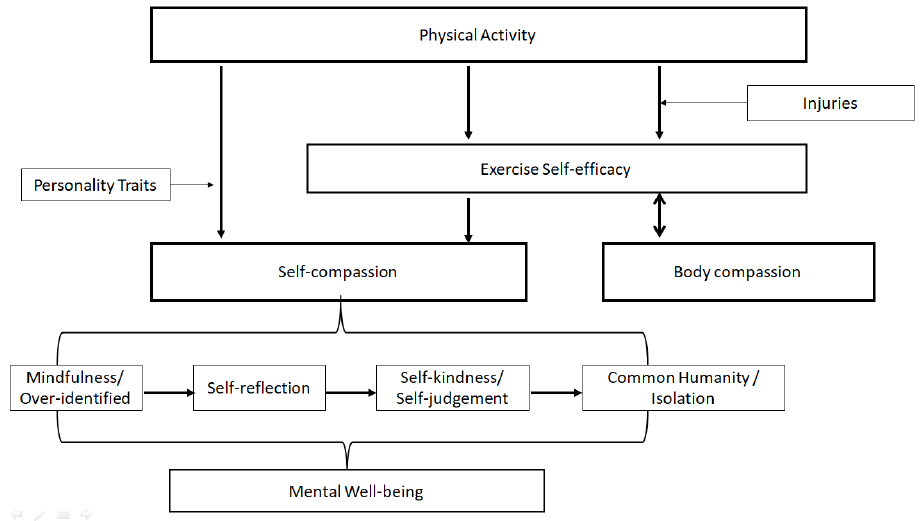
Figure 6. Exercise and Self-Esteem Model revised with self-compassion: An Abductive Qualitative Approach. Note. This figure demonstrates the final model of the interview outcomes. Self-compassion and body compassion have shown as two separate paths, without any inter-relationships. While, the figure also indicates the effect of physical activity and self-compassion in achieving mental